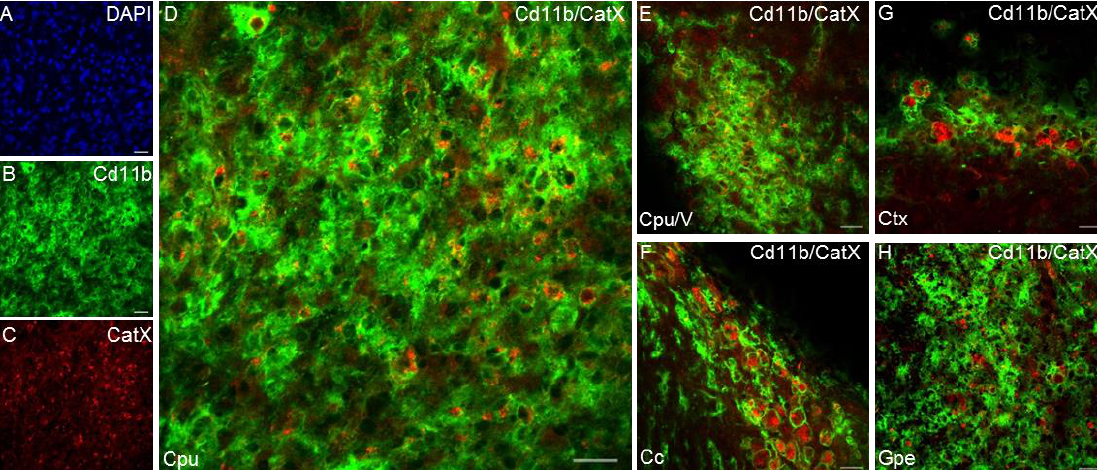
Figure 4. Microglial upregulation of cathepsin X in rat brain after intrastriatal LPS injection. Representative images of double immunofluorescence staining of microglial marker Cd11b (green fluorescence; B ) and cathepsin X (red fluorescence; C ) in the ipsilateral side of the striatal brain slices 4 weeks after LPS-induced lesion. Nuclei were counterstained with DAPI (blue fluorescence; A ). In the striatum (Cpu; D ), caudate-putamen/ventricular (Cpu/V; E ), corpus callosum (Cc; F ), cortex (Ctx; G ), and external globus pallidus (GPe; H ), upregulated cathepsin X was predominantly restricted to Cd11b-positive cells. However, some cathepsin X-positive signal did not overlap with Cd11b-positive signal in Cpu/V and GPe. Images were acquired using an LSM 710 Carl Zeiss confocal microscope and ZEN imaging software. Scale bars, 20 µ